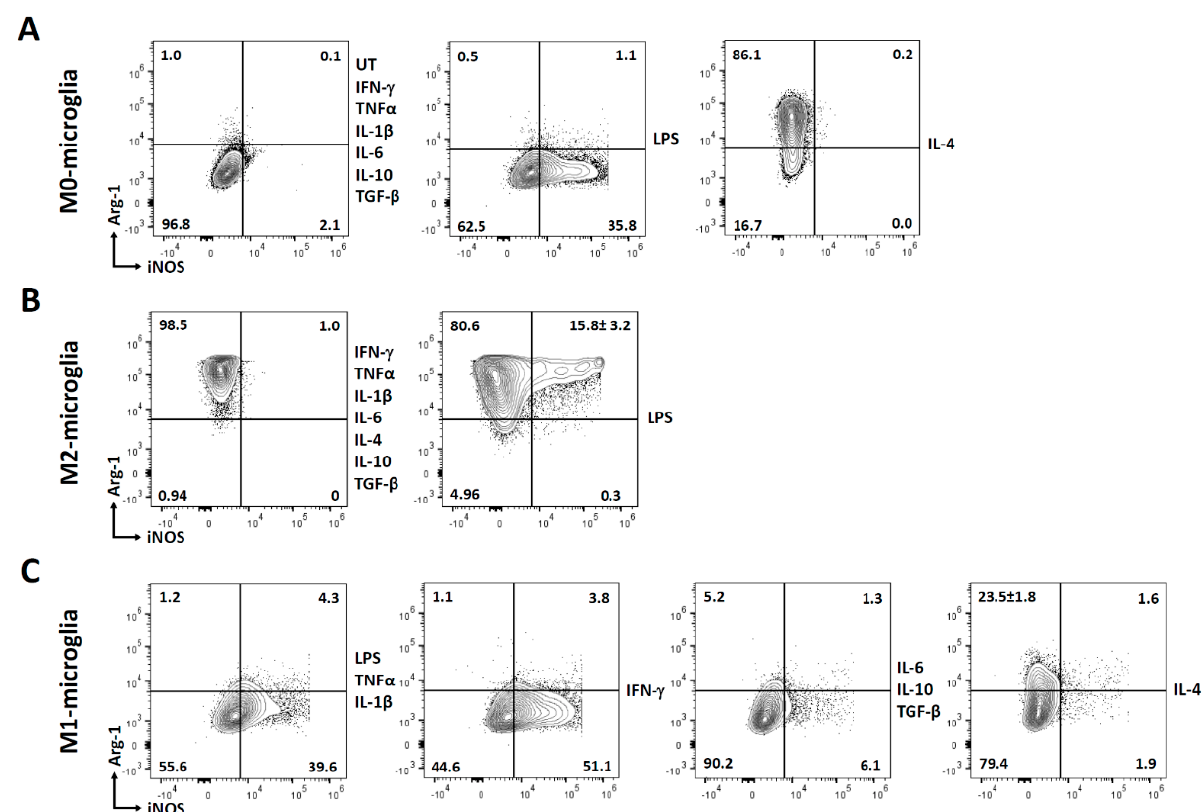
Figure 7. Arg-1 and iNOS expression in polarized and non-polarized microglial cells. Cells were divided into three groups: non-polarized (M0), M2-polarized (treated with IL-4), and M1-polarized (treated with LPS). These cells were then treated with various pro- and anti-inflammatory cytokines for 24 h, followed by staining for both iNOS and Arg-1. ( A ) Representative contour plots of M0-microglial cells expressing Arg-1 and iNOS after treatment with various pro- and anti-inflammatory mediators. ( B ) Representative contour plots of M2-microglia expressing Arg-1 and iNOS after treatment with various pro- and anti-inflammatory mediators. ( C ) Representative contour plots of M1-microglial cells expressing Arg-1 and iNOS after treatment with various pro- and anti-inflammatory mediators. UT-untreated control. Experiments were carried out three times with duplicate wells.